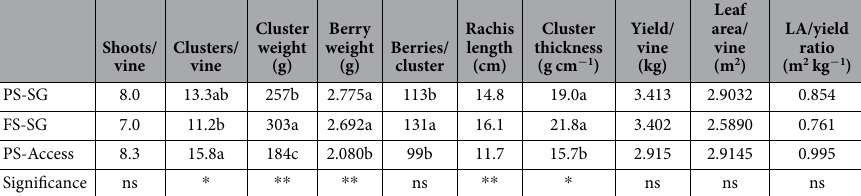
Table 4. Vegetative growth, yield components and vine balance recorded on vines of SG (susceptible clone R10) and accession 72-096 (resistant). PF = partially sprayed. FS = fully sprayed. Cluster thickness is given as total fresh berry mass to rachis length ratio (g/cm). LA = leaf area * and ** denote significant differences between treatments at P < 0.05 and 0.01 according to within column mean separation performed with SNK test and showed by small letters. ns = not significant.